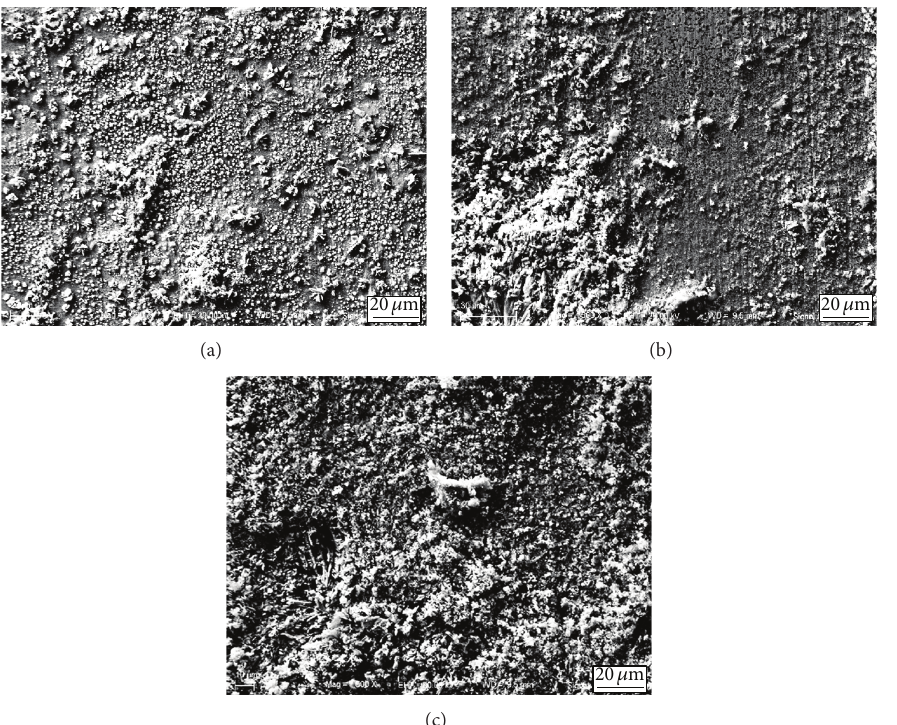
Figure 5: SEM surface morphologies of potentiodynamic polarized composite arch wires: (a) pH 4.0; (b) pH 6.75; (c) 0.9% NaCl.